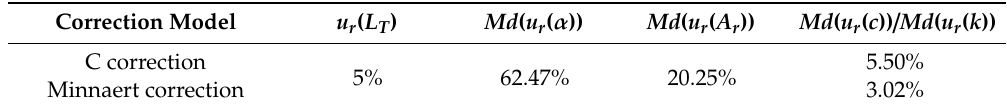
Table 1. Relative uncertainty of input quantities.